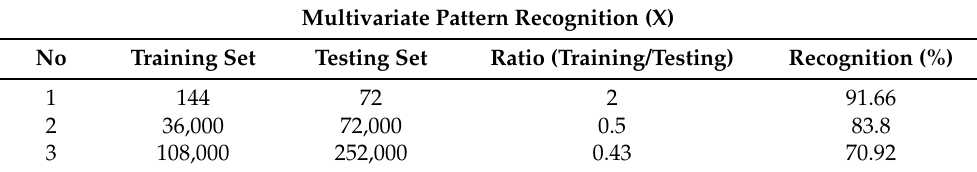
Table 5. D 2 Recognition with SVM and X